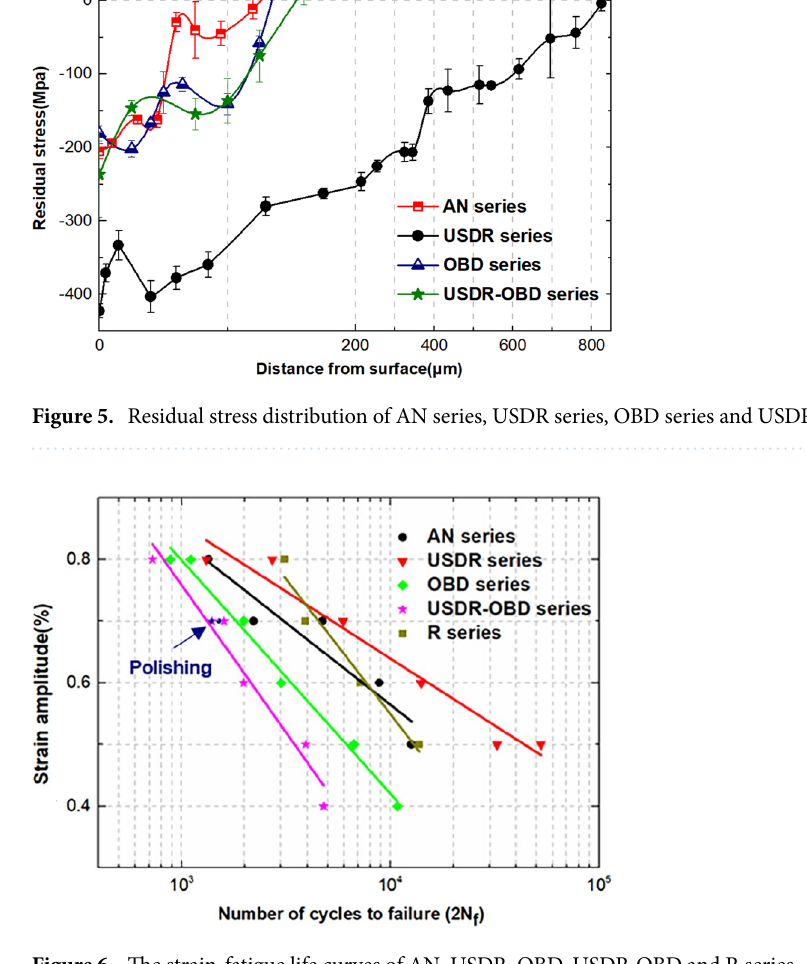
Figure 6. The strain-fatigue life curves of AN, USDR, OBD, USDR-OBD and R